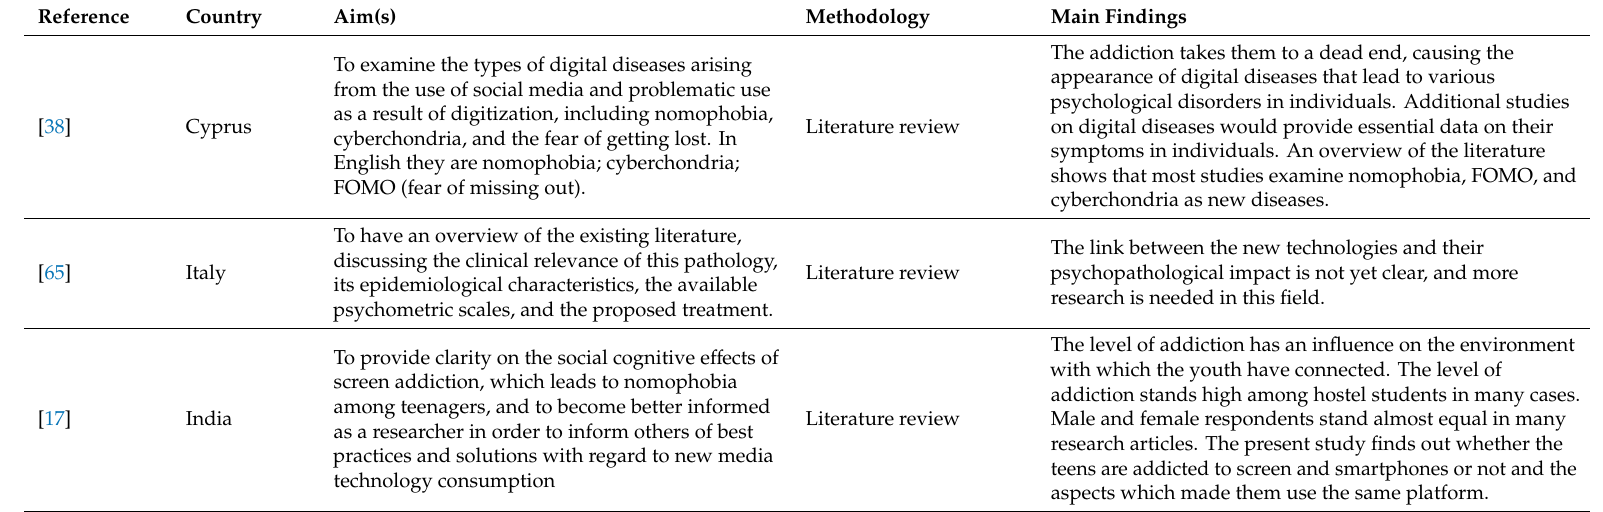
Table A3. Literature